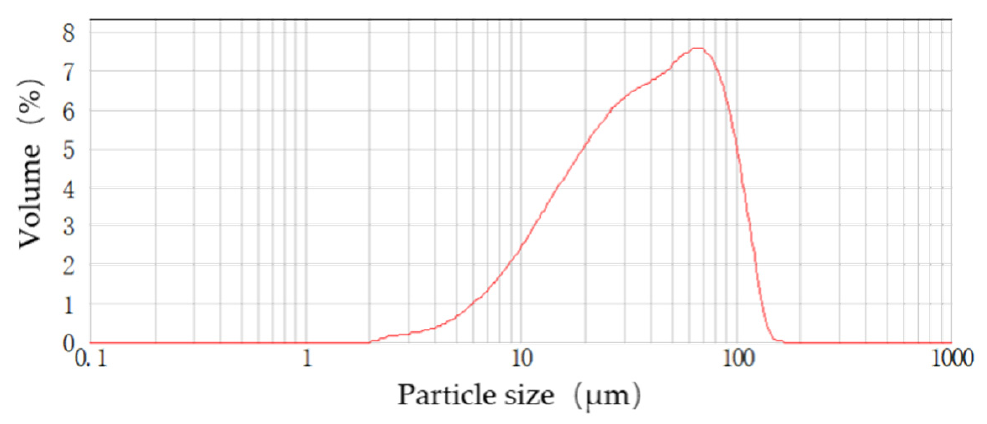
Figure 12. Particle size distribution of SiC sample #2.